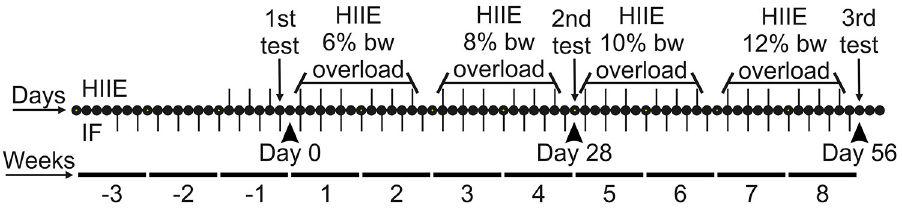
Fig 1. Graphical representation of the experimental design. Days (dots) and weeks (horizontal lines) of the study period (56 days in total) showing the exact days of fasting (lower dash) and HIIE (upper dash) interventions. The load utilized for each HIIE is described above the respective days. The 1st, 2nd, and 3rd PTs for endurance are indicated. The adaptation phase is represented by weeks with negative numbers.